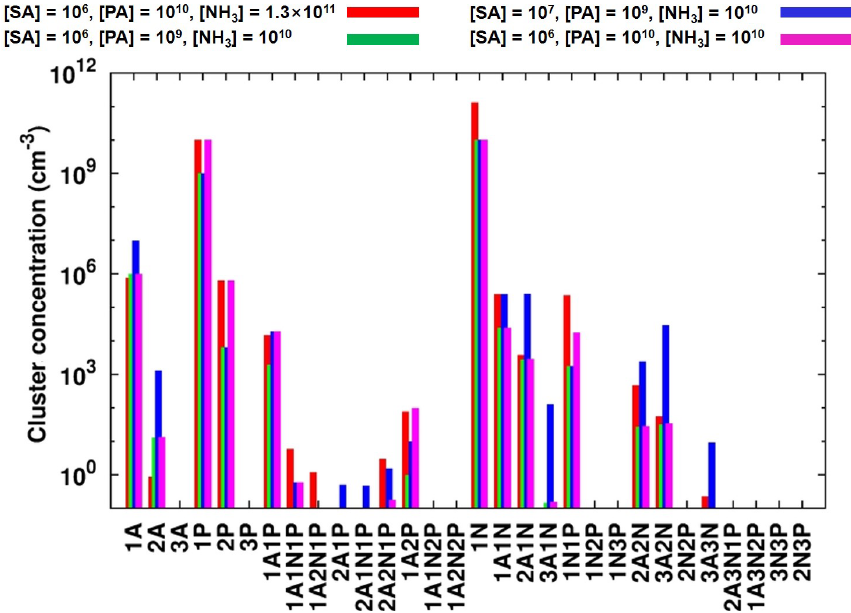
Figure 4. Simulated steady-state clusters distribution in the sulfuric-acid–pyruvic-acid–ammonia system at 238K, under different initial monomers concentrations. “A” refers to sulfuric acid, “P” refers to pyruvic acid and “N” refers to